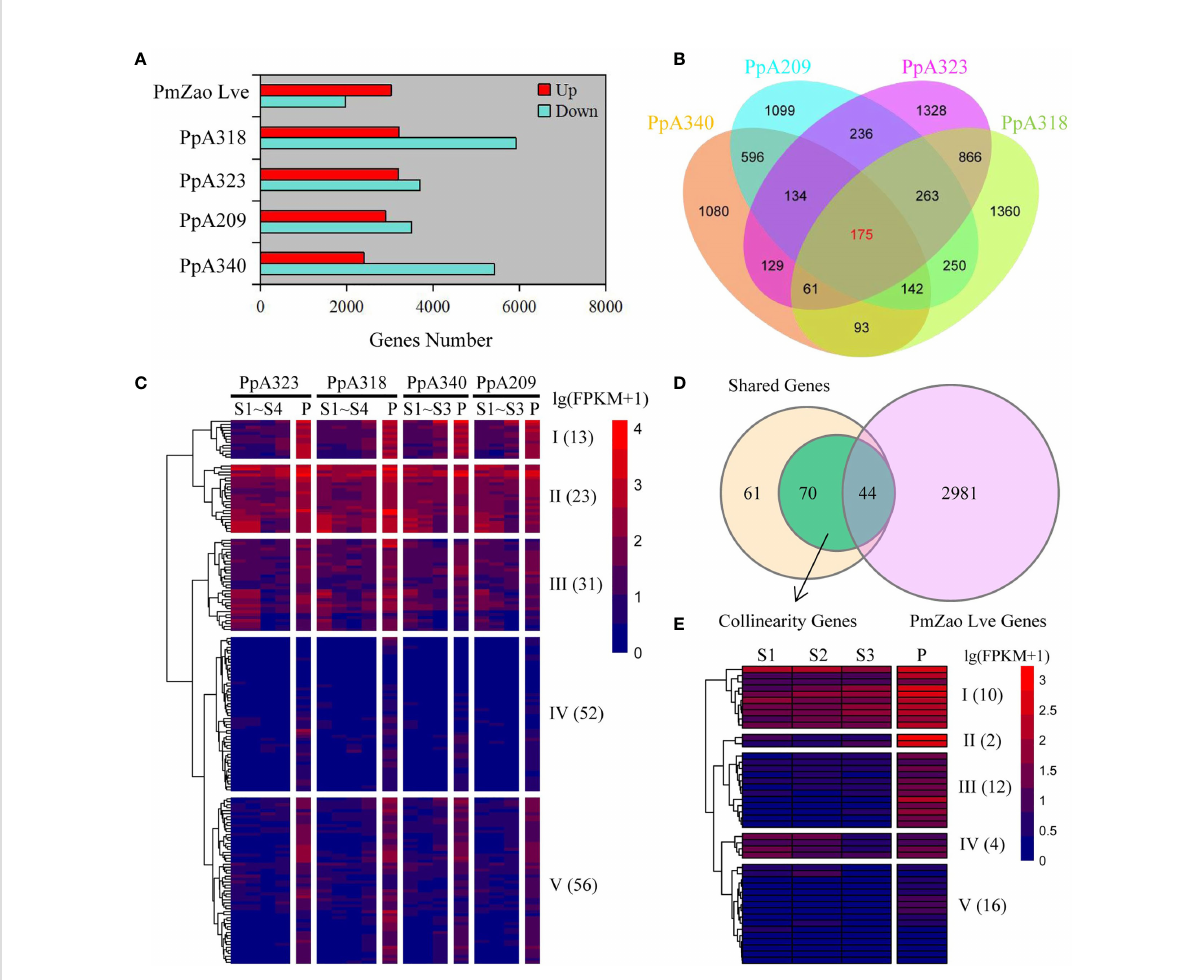
FIGURE 2 Identi fi cation of fl owering-related DEGs and gene expression patterns. (A) DEGs from dormancy to pre- fl owering stage in four P. persica genotypes (A209, A340, A318, and A323) and one P. mume cultivar ( ‘ Zao Lve ’ mei). (B) Venn diagram of four P. persica genotype DEGs from dormancy to pre- fl owering stage. (C) Gene expression patterns of shared DEGs in four P. persica genotypes. (D) Overlap of shared DEGs in P. persica and P. mume from dormancy to pre- fl owering stage with collinearity genes between P. persica and P. mume . (D, E) the gene expression patterns of shared genes in P. mume . The letter S stands for dormancy stage and P for pre- fl owering